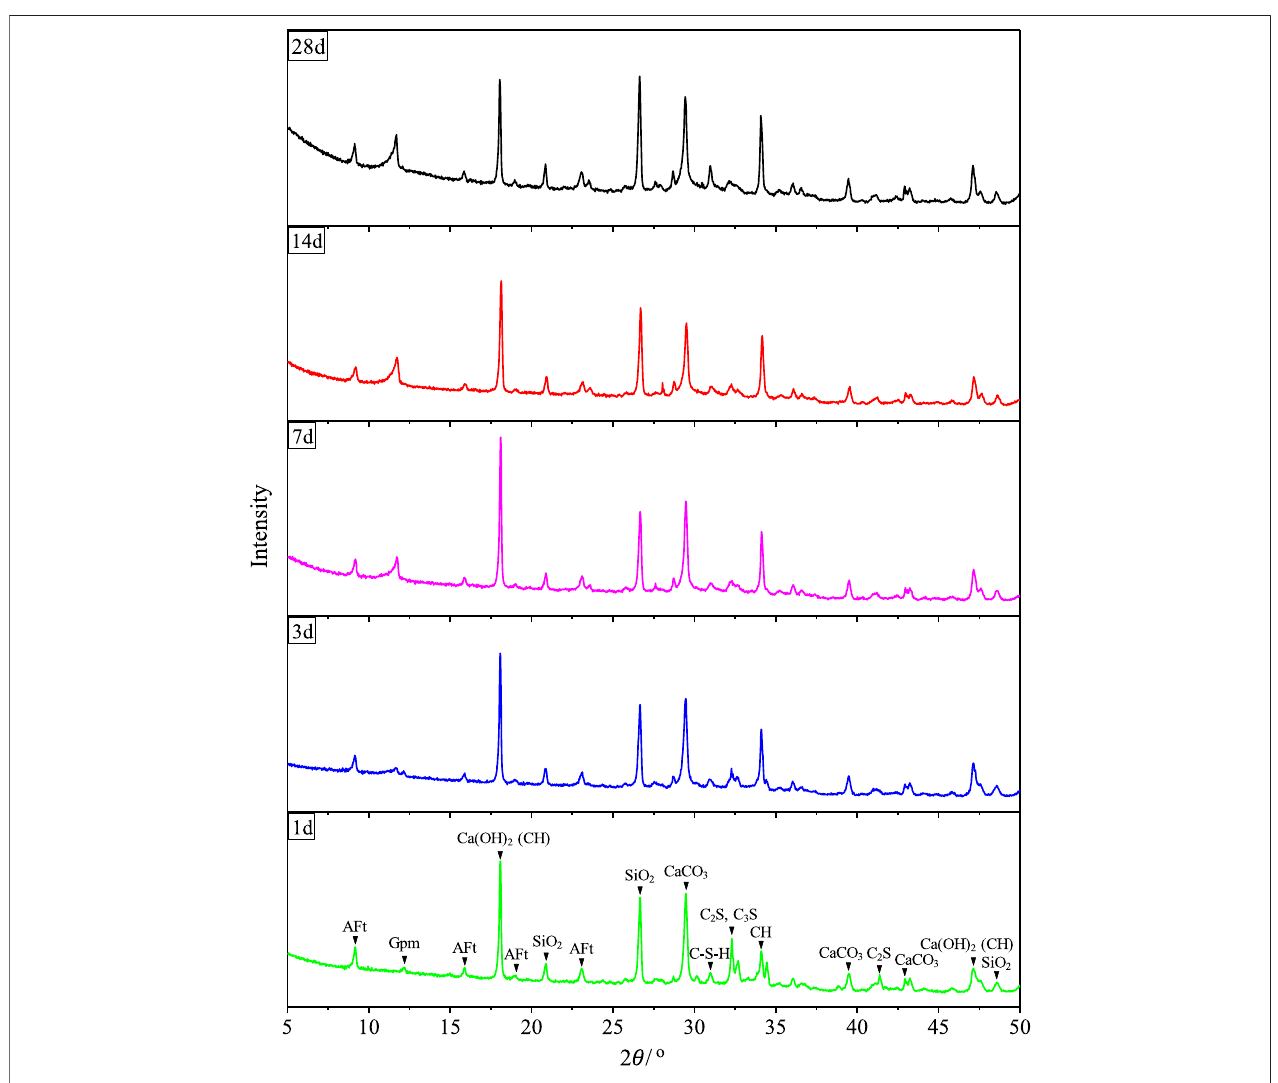
FIGURE 2 | XRD patterns of hydration products on